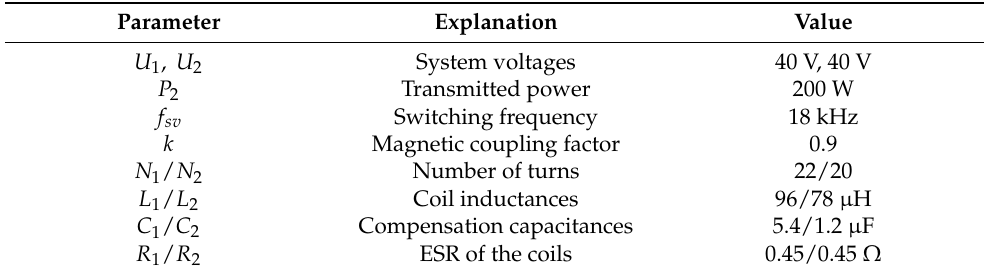
Table 2. Electrical parameters of the designed prototype.